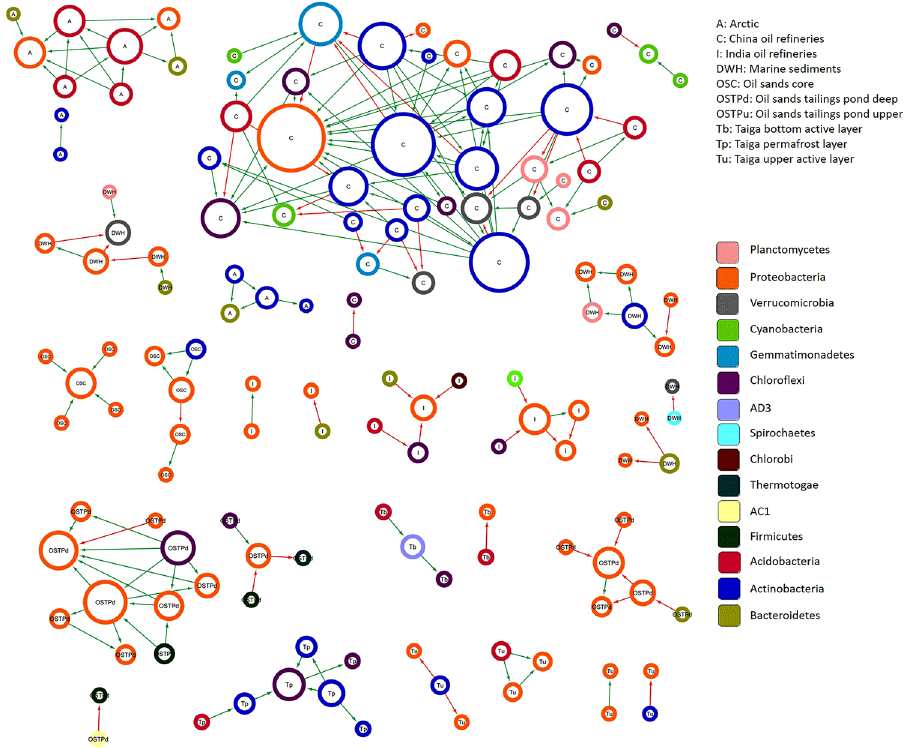
Figure 5. SparCC network plot of global bacterial interactions in individual oil polluted habitats. Significant bacterial associations captured by SparCC ( p -value < 0.01) with an absolute correlation magnitude of ≥ 0.6 are presented. Nodes represent detected phylotypes (OTU clustered at 97% similarity) involved in either significant co-occurrence (green edges) or co-exclusion (red edges) relationships. Border coloration depicts taxonomic affiliation of nodes at the phylum level (see legend). Node size is proportional to the connectivity of the node (both positive and negative